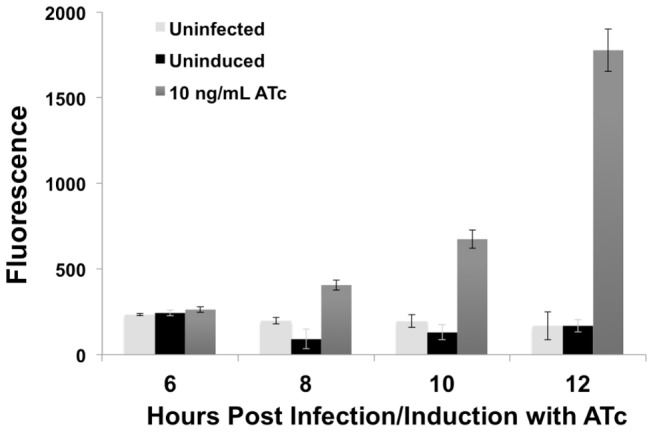
Detection of GFP induction early in the developmental cycle.L929 cell cultures infected with transformed C. trachomatis were induced at the start of infection (0 hpi). Samples were taken and lysates prepared at the indicated time points after the start of infection. GFP fluorescence was measured using a microplate fluorometer with the results quantified in arbitrary units. Error bars indicate standard deviation from two separate experiments.